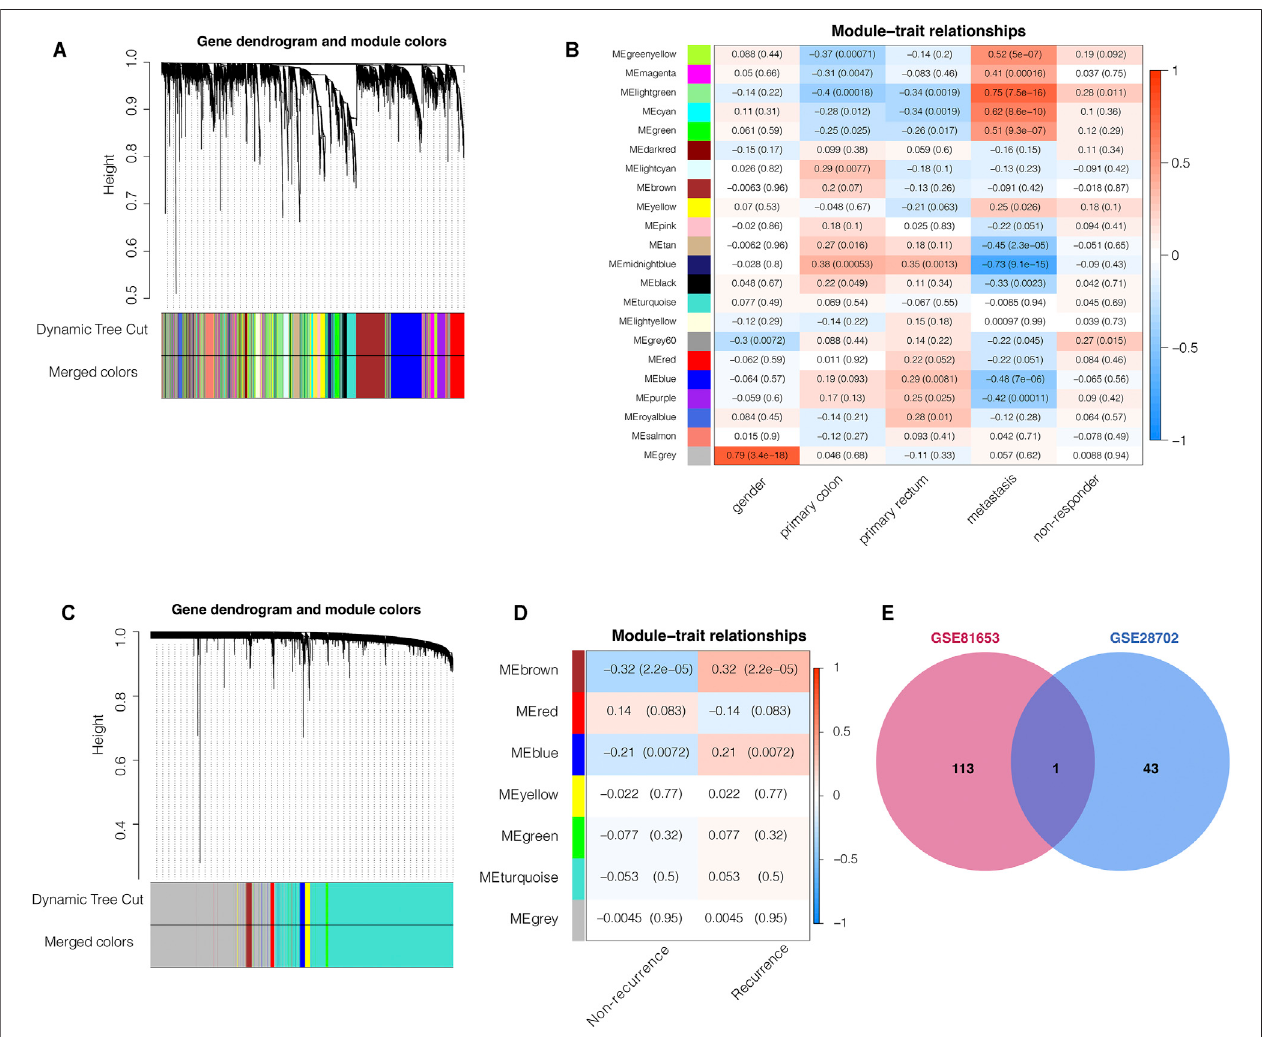
FIGURE 1 | Weighted gene co-expression network analysis (WGCNA) predicts that C3 gene aggravates FOLFOX chemotherapy resistance and recurrence of colorectalcancer. (A) Clusteringdendrogramofthetop5,000mostvariantgenesintheGSE28702dataset,withdissimilaritiesbasedontopologicaloverlaplabelledwith assignedmodule colors (B) Heatmap forthe correlation ofWGCNAmodules withclinicaltraits (GSE28702). (C) Clusteringdendrogram oftop 5,000mostvariant genes in the GSE81653 dataset, with dissimilarities based on topological overlap labelled with assigned module colors (D) Heatmap for the correlation of WGCNA modules with clinical traits (GSE81653). (E) Venn plot indicated that the C3 gene was the only common element between the chemotherapy respondence-associated module (WGCNA of GSE28702) and the colorectal cancer recurrence-associated module (WGCNA of GSE81653). Genes with module membership values > 0.7 were used for this intersection analysis. A p -value less than 0.05 indicated statistical signi fi